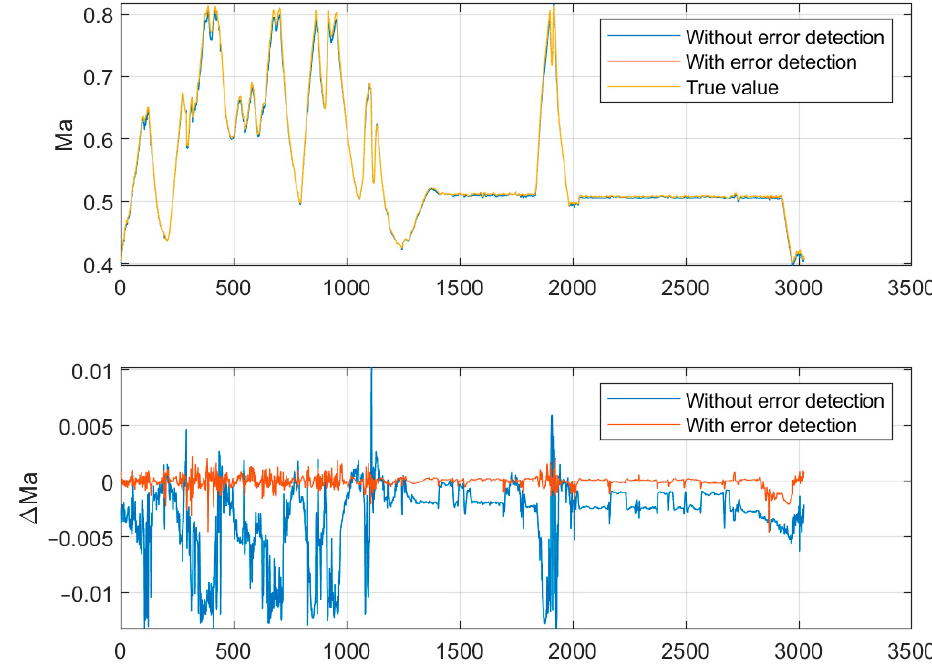
Figure 17. Comparison of Mach numbers.